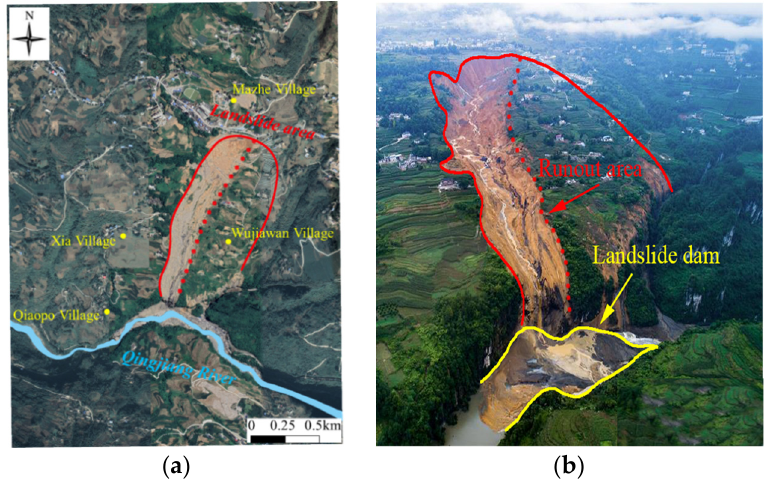
Figure 2. Topographic map of Shaziba landslide and surrounding area: ( a ) top view of the Shaziba landslide and surrounding villages; ( b ) landslide dam on the Qingjiang River.